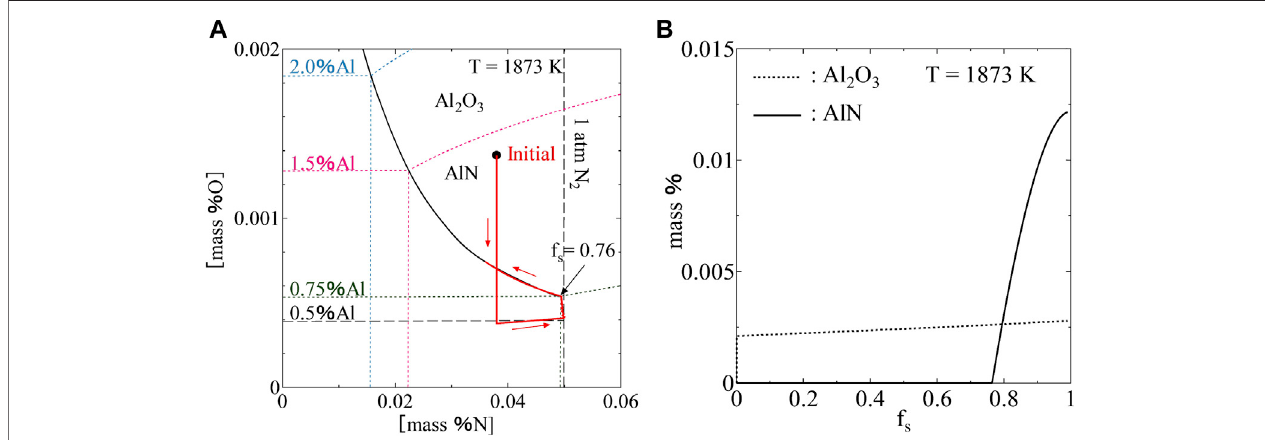
FIGURE 10 | A path of variations of the concentrations of Al, N, and O in the liquid phase (A) , precipitated amounts of AlN and Al 2 O 3 (B) during the solidi fi cation process.